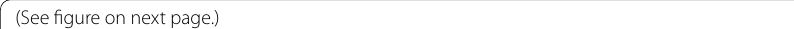
Fig. 3 State-of-the-art construction paradigm for configurations of streets: the frames ( s ∗ ⋆ ) show this paradigm steps for constructing street r c on street map ( m ) from the notional example in Fig. 1. Our illustration assumes that streets r a and r b were constructed previously and that the remaining streets will be constructed afterward. The superscript and subscript of each frame label indicate the street under construction and the step order, respectively. Each street-segment in colour already belongs to a street: when the colour is vivid and the line is solid, the street was committed; when the colour is pallid or the line is vividly dashed, the street is under construction. Each street-segment in grey is a candidate for belonging to a new street. We attribute to each street a particular colour. The construction goes like this. Initial stage ( s c 0 ): no street-segment is yet assigned to street r c . Seeding step ( s c 1 ): pick at random one candidate street-segment— the seed street-segment is in pallid orange and marked with an orange bold square. Orientation step ( s c 2